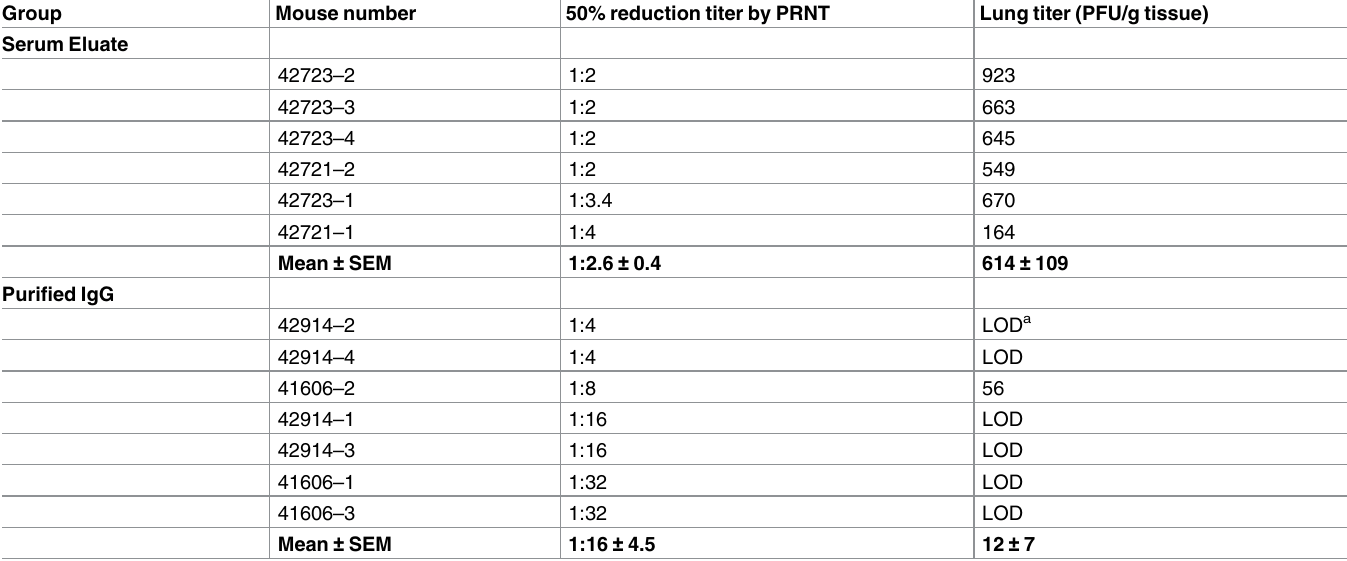
Table 2. Neutralizing antibody titers in the antibody transferred mice before challenge. Group Mouse number Serum Eluate